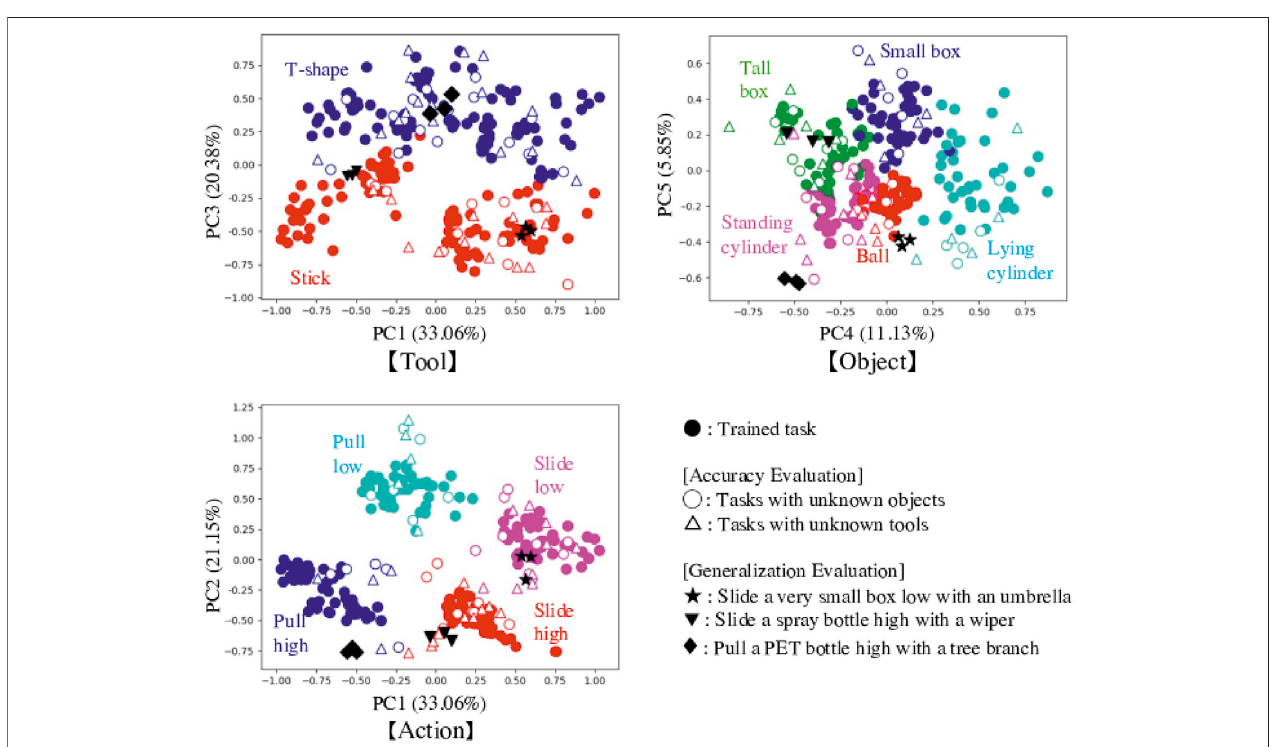
FIGURE 5 | Results of PCA for the internal latent space values, Cs(0). We change the axis to show for expressing map of tools, objects and actions. Trained tasks (solid circles) are separated and clustered according to the features of tools, objects, and actions. Focusing on the map axes, we can also say that PC1 and PC2 represent action features, with PC1 indicating action type (sliding or pulling) and PC2 representing heights. PC3 represents tool features, and PC4 and PC5 represent object features. Cs(0) values could simultaneously express tools, objects, and actions which can reproduce goal effects. Values for explored Cs(0) in the tested tasks are superimposed on the maps as hollow circles and triangles, and black stars, inverted triangles, and diamonds. Many plots are plotted in the proper regions, suggesting good feature detection.